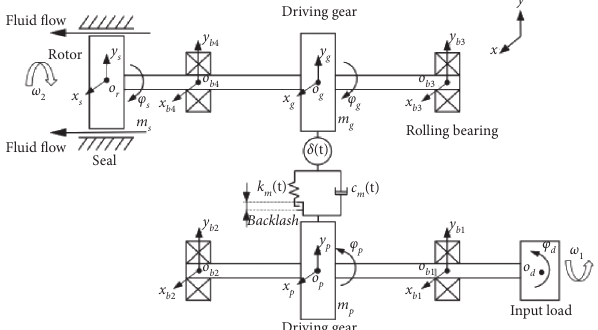
Figure 2: Schematic diagram of structure and forces of GRSB system.